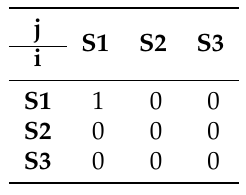
Table 3. Transition matrix of a washing machine taking into account user presence information for two consecutive time